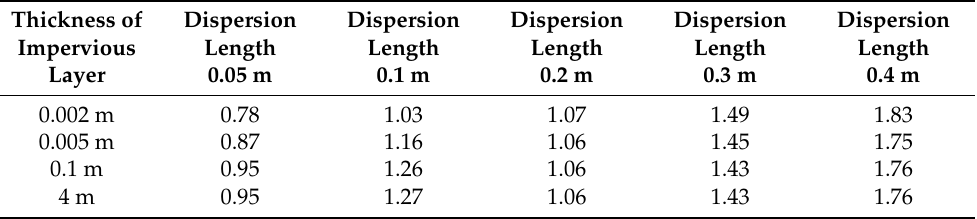
Table 2. The accuracy verification results using the root mean squared error (RMSE) of the results obtained by changing the approximate dispersion length and the permeable layer